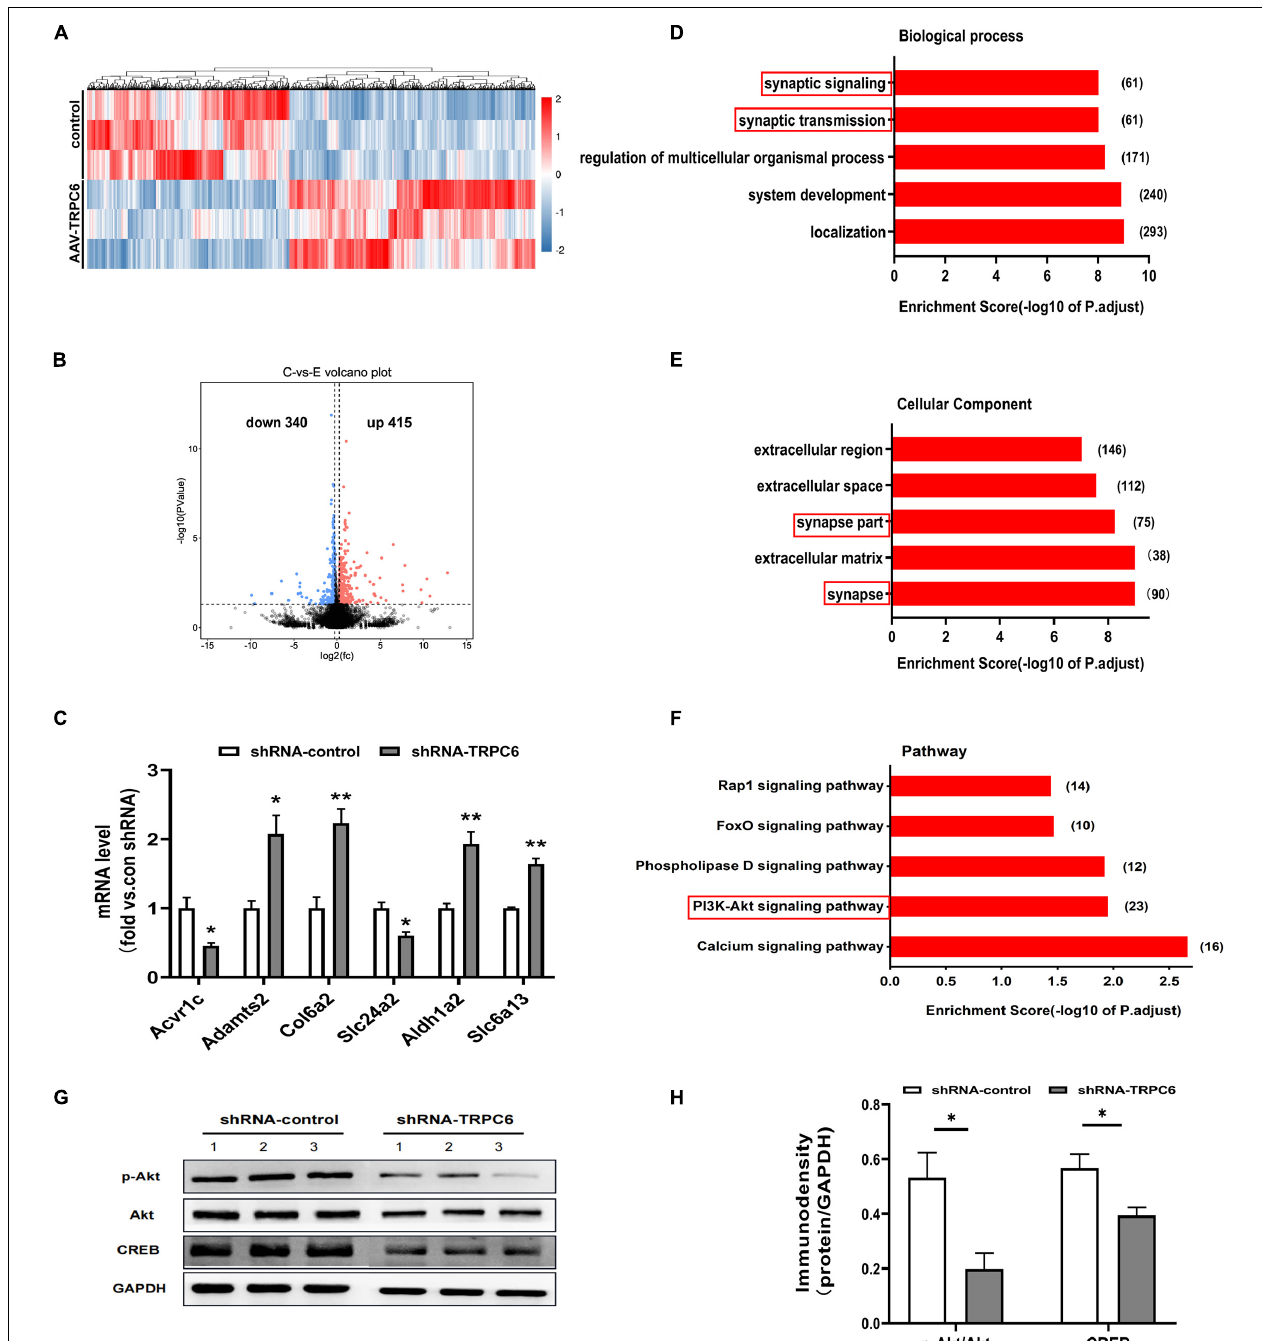
FIGURE 7 | Down-regulation of TRPC6 altered gene expression associated with synaptic structure and function. (A) Heatmap of significantly up or downregulated genes in two groups. (B) A volcano plot showing differentially expressed genes in hippocampus of shRNA-control and shRNA-TRPC6 treated mice. Dashed line represents p < 0.05. Significantly up-regulated genes are shown in red for 415 genes, and significantly down-regulated genes are shown in blue for 340 genes, with down-regulated and up-regulated genes above | logFC| > 0.58 threshold. (C) Validation of gene expression in hippocampus of shRNA-control and shRNA-TRPC6 treated mice by qRT-PCR. (D,E) Enriched top five GO pathway in biological process and cellular component. The notable pathways which contain several pathways related to synaptic developmental function. The numbers listed next to the bars represent the number of differential genes in each pathway. The former significant pathway involved in synaptic developmental function is highlighted in red frame. (F) Five of the first twenty KEGG pathways were selected for significant enrichment differences, where the PI3K-Akt signaling pathway was found to be associated with cell survival and synaptic development has been highlighted in red frame. (G) Protein levels of Akt, pAkt, and CREB in the hippocampus isolated from shRNA-control or the shRNA-TRPC6 treated mice. (H) shRNA-TRPC6 treated mice displayed low levels of pAkt/Akt, and CREB in the hippocampus. Sample sizes for each group: n = 3. Data were presented as mean ± SEM. * p < 0.05, ** p < 0.01.